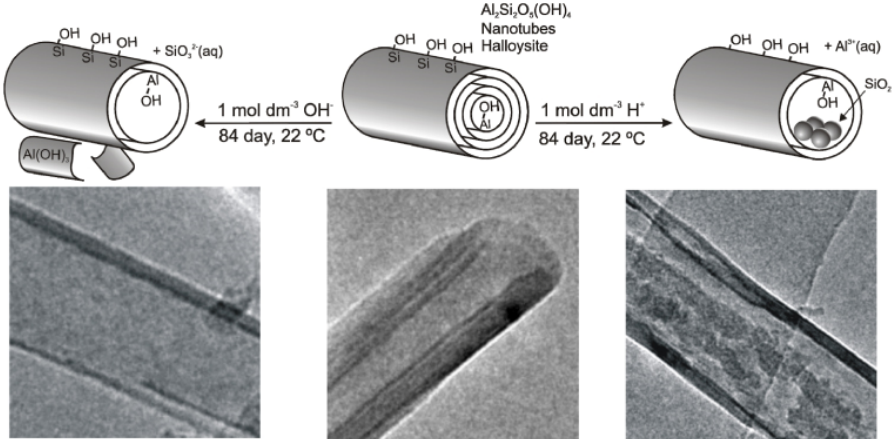
Figure 26. Scheme of transformation of halloysite (Al 2 Si 2 O 5 (OH) 4 ) nanotubes in strong acid and alkaline solutions leading to formation of amorphous nanoparticles of SiO 2 and amorphous nanosheets of Al(OH) 3 , respectively. Reproduced with permission from [179].